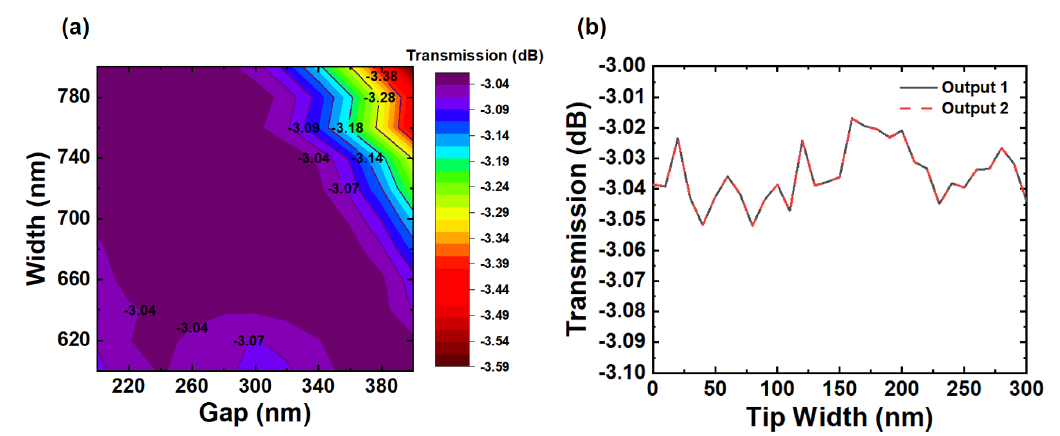
Figure 7. Fabrication tolerance to deviation ( a ) of the waveguide width and the gap and ( b ) of the tip width of the power splitter using EME simulation.